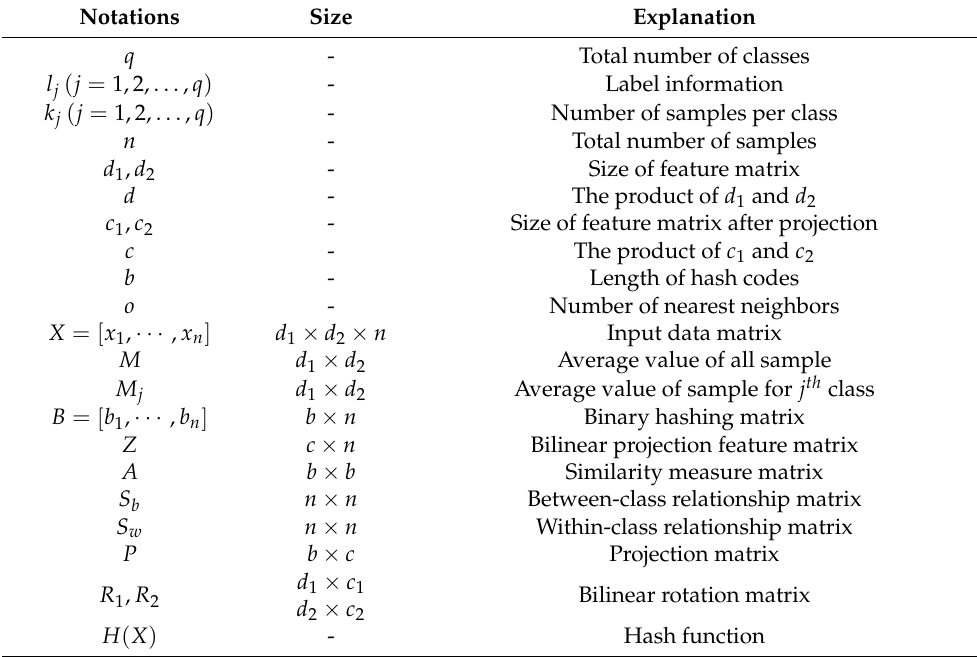
Table 1. Explanation of main